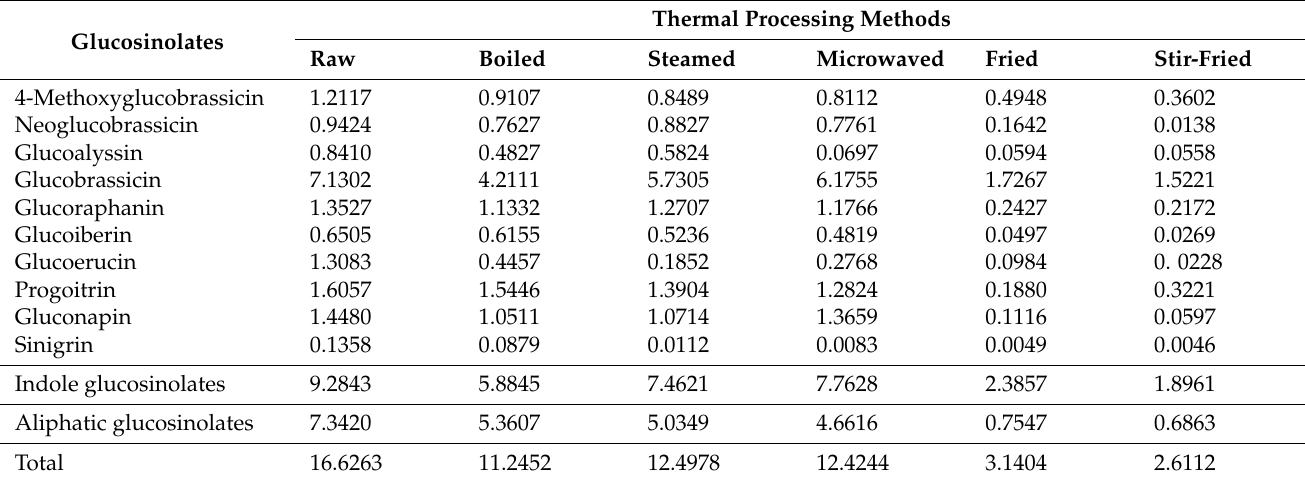
Table 3. Effects of different cooking methods on on glucosinolate ( µ mol/g DW) in red cabbage.